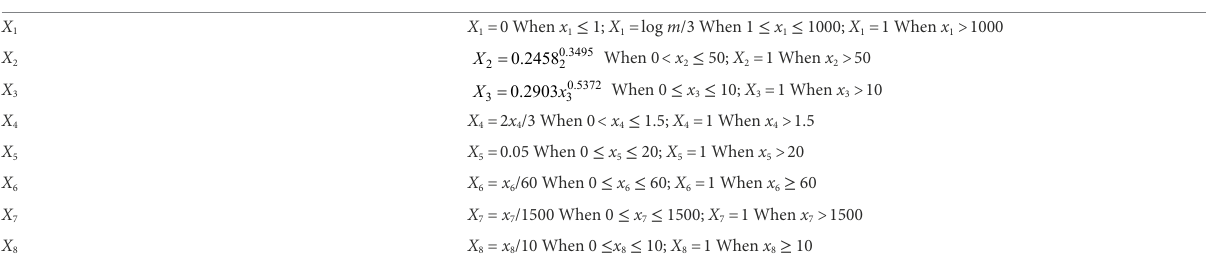
TABLE 2 Values depend on the frequency of debris flow. Frequency type Standard of classification Grading standard Extremely high frequency A few to a dozen times a year. 6 High frequency Once or twice to several times a year 5 Subhigh frequency Once a few years to once or twice a year 4 Intermediate frequency Every 10 years to every few years. 3 Low frequency Every few decades to every ten years. 2 Once a 100 years to once a few decades.